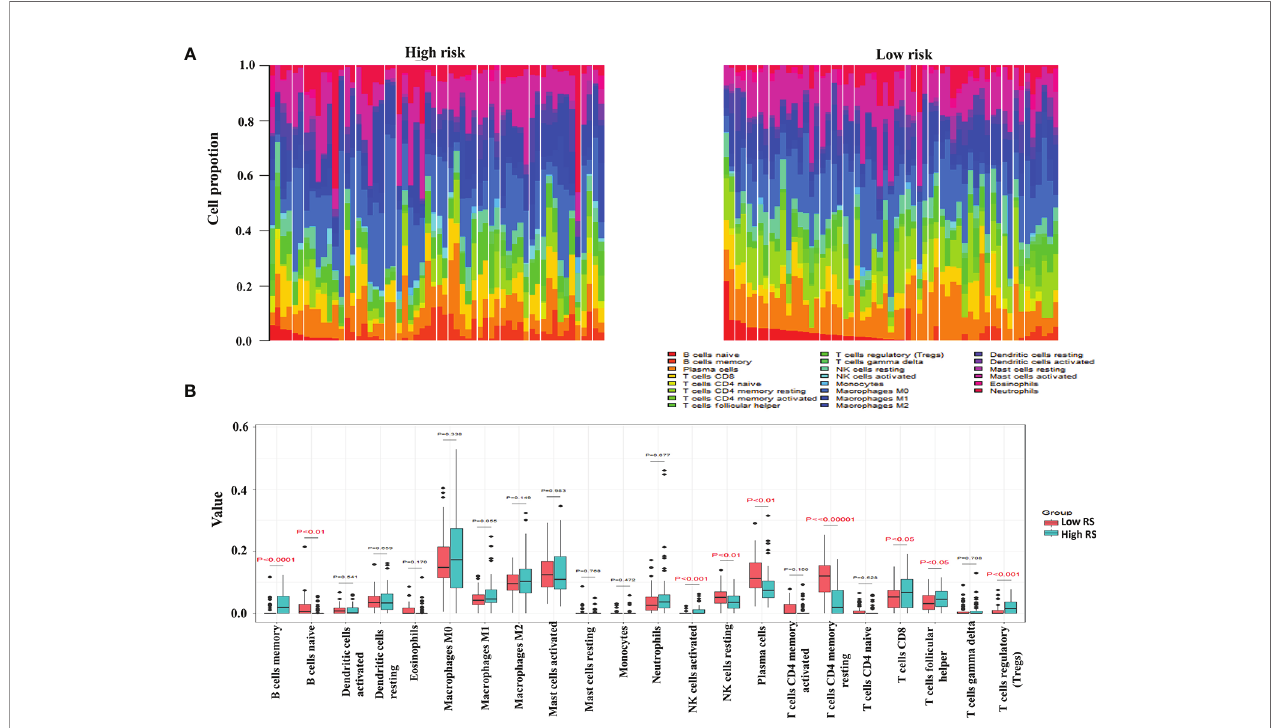
FIGURE 10 | Differences in leukocyte cell subsets between the high-risk group and the low-risk group in the gene set enrichment (GSE) cohort. (A) Mean proportions of 22 immune cells in the GSE cohort. (B) Differential immune cell type expression was observed between the high-risk group and the low-risk group in the GSE